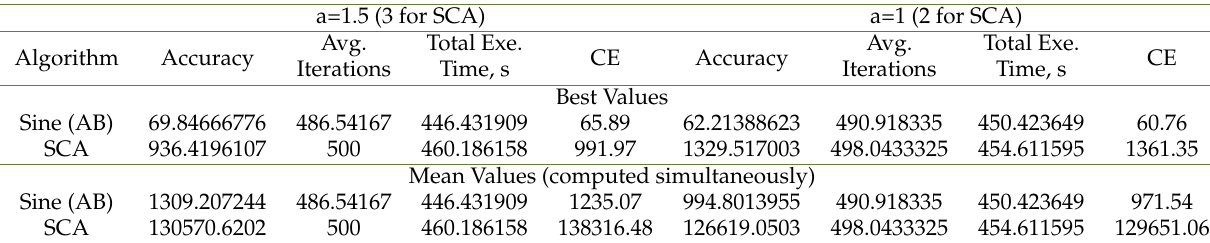
Table 10. Cost-Effectiveness (CE) of SCA and Sine (AB) Algorithms a=1.5 (3 for SCA) a=1 (2 for